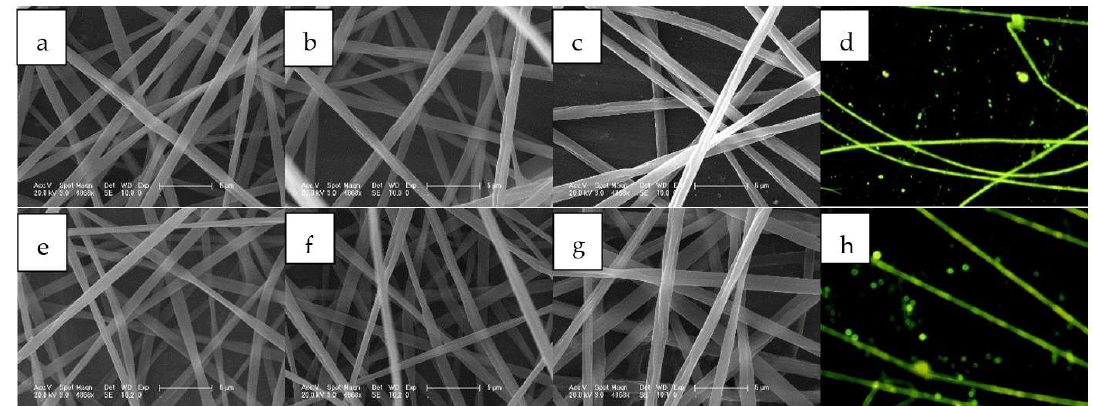
Figure 2. SEM and fluorescence microscope images of Ir(ppy) 2 (BPE) and Ir(ppy) 2 (TPP) in PVP fiber. ( a ) SEM of Ir(ppy) 2 (BPE) in PVP (5%); ( b ) SEM of Ir(ppy) 2 (BPE) in PVP (10%); ( c ) SEM of Ir(ppy) 2 (BPE) in PVP (15%); ( d ) fluorescence microscope image of Ir(ppy) 2 (BPE) in PVP (10%); ( e ) SEM of Ir(ppy) 2 (TPP) in PVP (5%); ( f ) SEM of Ir(ppy) 2 (TPP) in PVP (10%); ( g ) SEM of Ir(ppy) 2 (TPP) in PVP (15%); ( h ) fluorescence microscope image of Ir(ppy) 2 (TPP) in PVP